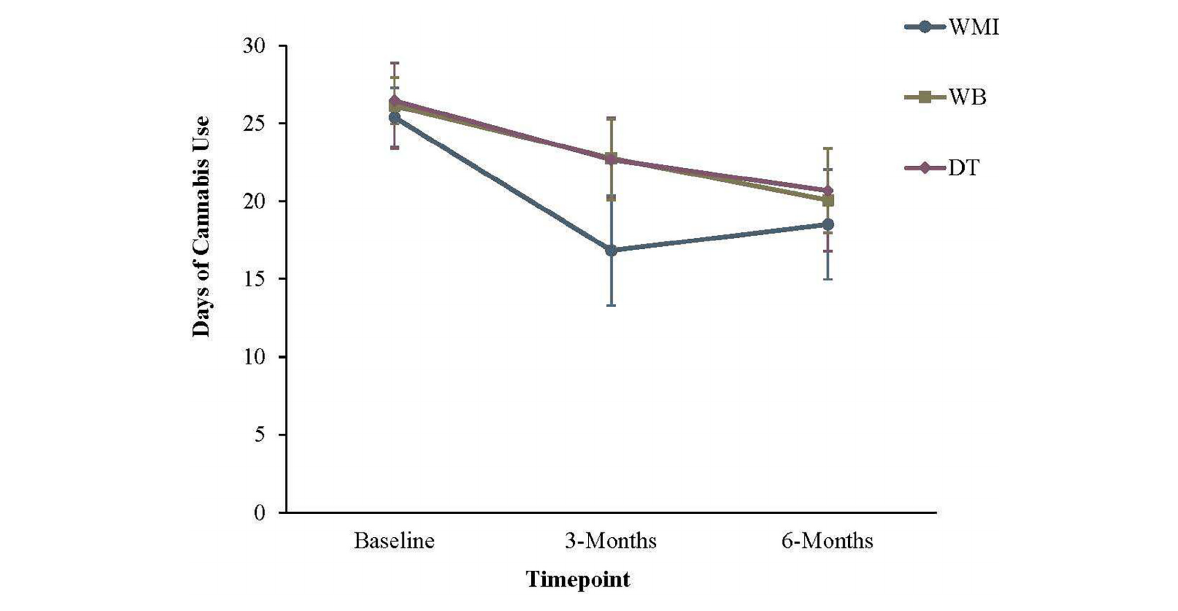
FIGURE2 Frequency of cannabis use in the previous 30 days. Error bars represent the 95% confidence interval for that group at a given timepoint. WMI, workbook plus motivational interview group; WB = workbook only group; DT = delayed workbook treatment